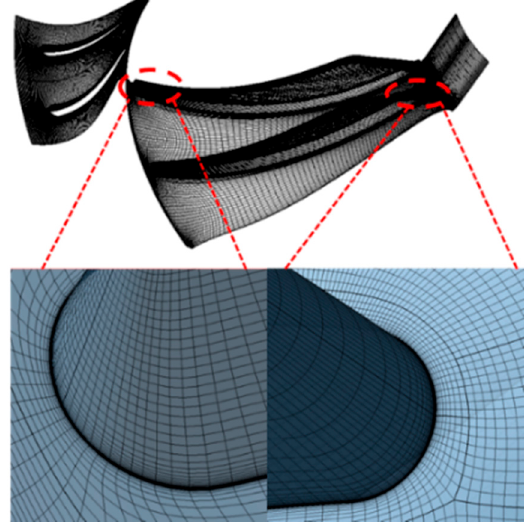
Figure 3. Computational mesh.